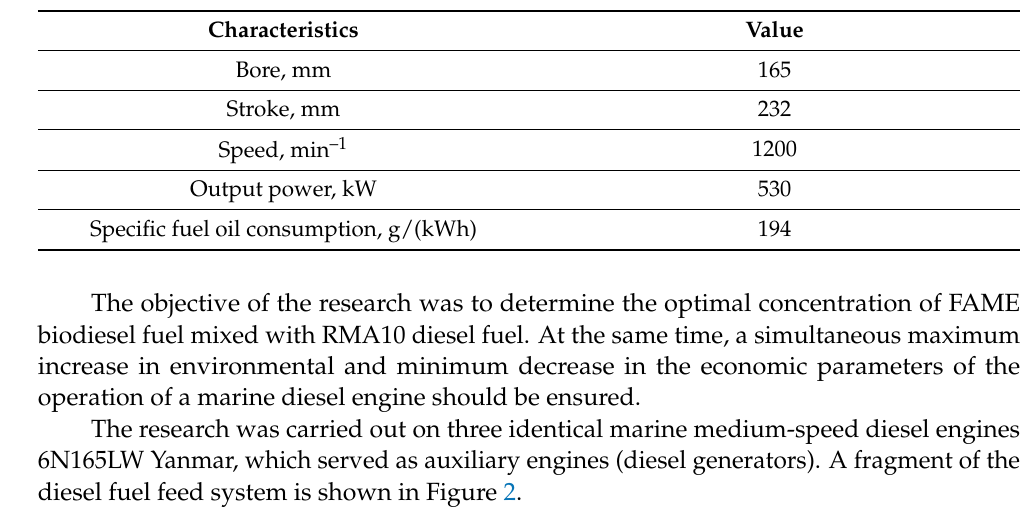
Table 2. Main characteristics of diesel engines 6N165LW Yanmar.